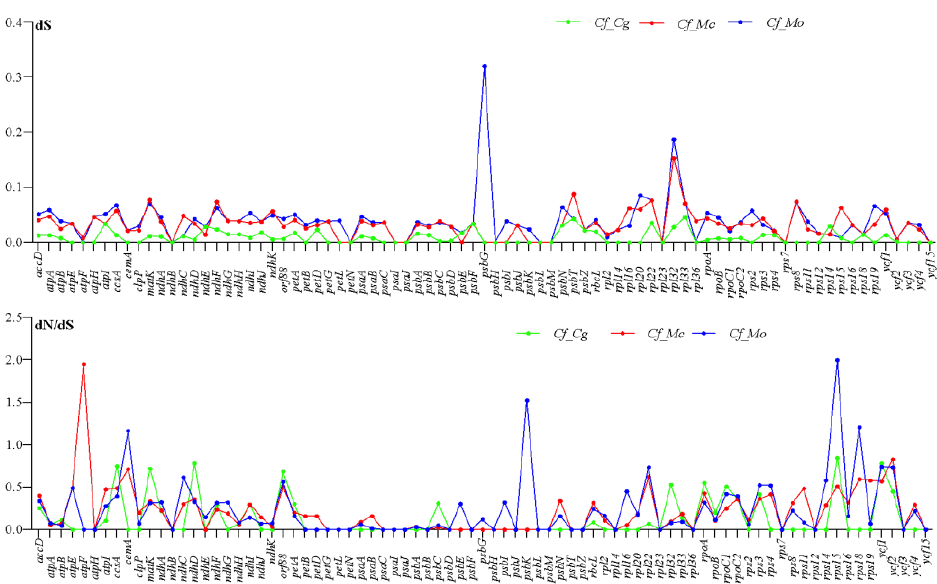
Figure 8. The synonymous (dS) and dN/dS ratio values of 81 protein-coding genes from four Capparaceae cp genomes.